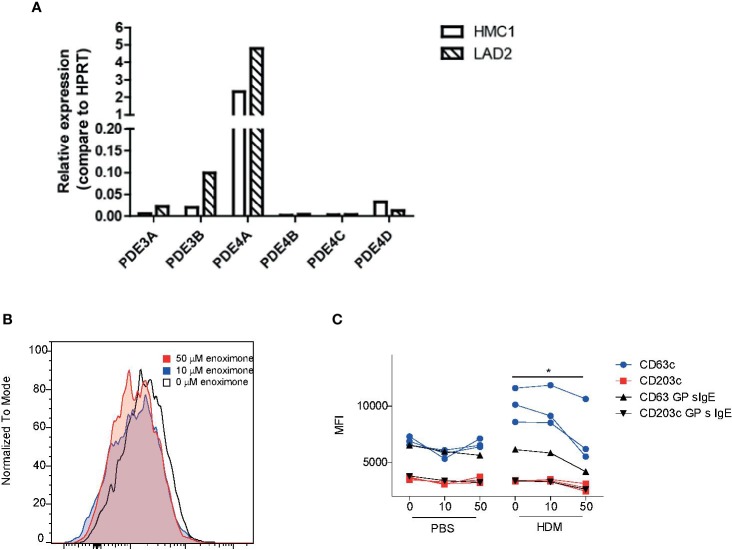
Effect of enoximone on FcεR-mediated activation of human mast cell lines (A) Expression of PDE3 and PDE4 isoforms in the human mast cell lines indicated, as determined by real-time (RT)-PCR. (B, C) Activation of HDM-stimulated serum immunoglobulin E (IgE) passively sensitized LAD2 cells, as determined by flow cytometry. Data are shown as histograms overlays for CD63 (B) and median fluorescence intensity (MFI) (CD63 and CD203c) of flow cytometry (FACS) measurements of enoximone (µM) pretreated and HDM (10 ng/ml) stimulated passive sensitized (HDM specific serum IgE) LAD2 cells (C). A Wilcox signed test was used; *P < 0.05. Data are shown from one out of two independent experiments. MFI, median fluorescence intensity; HDM, house dust mite.